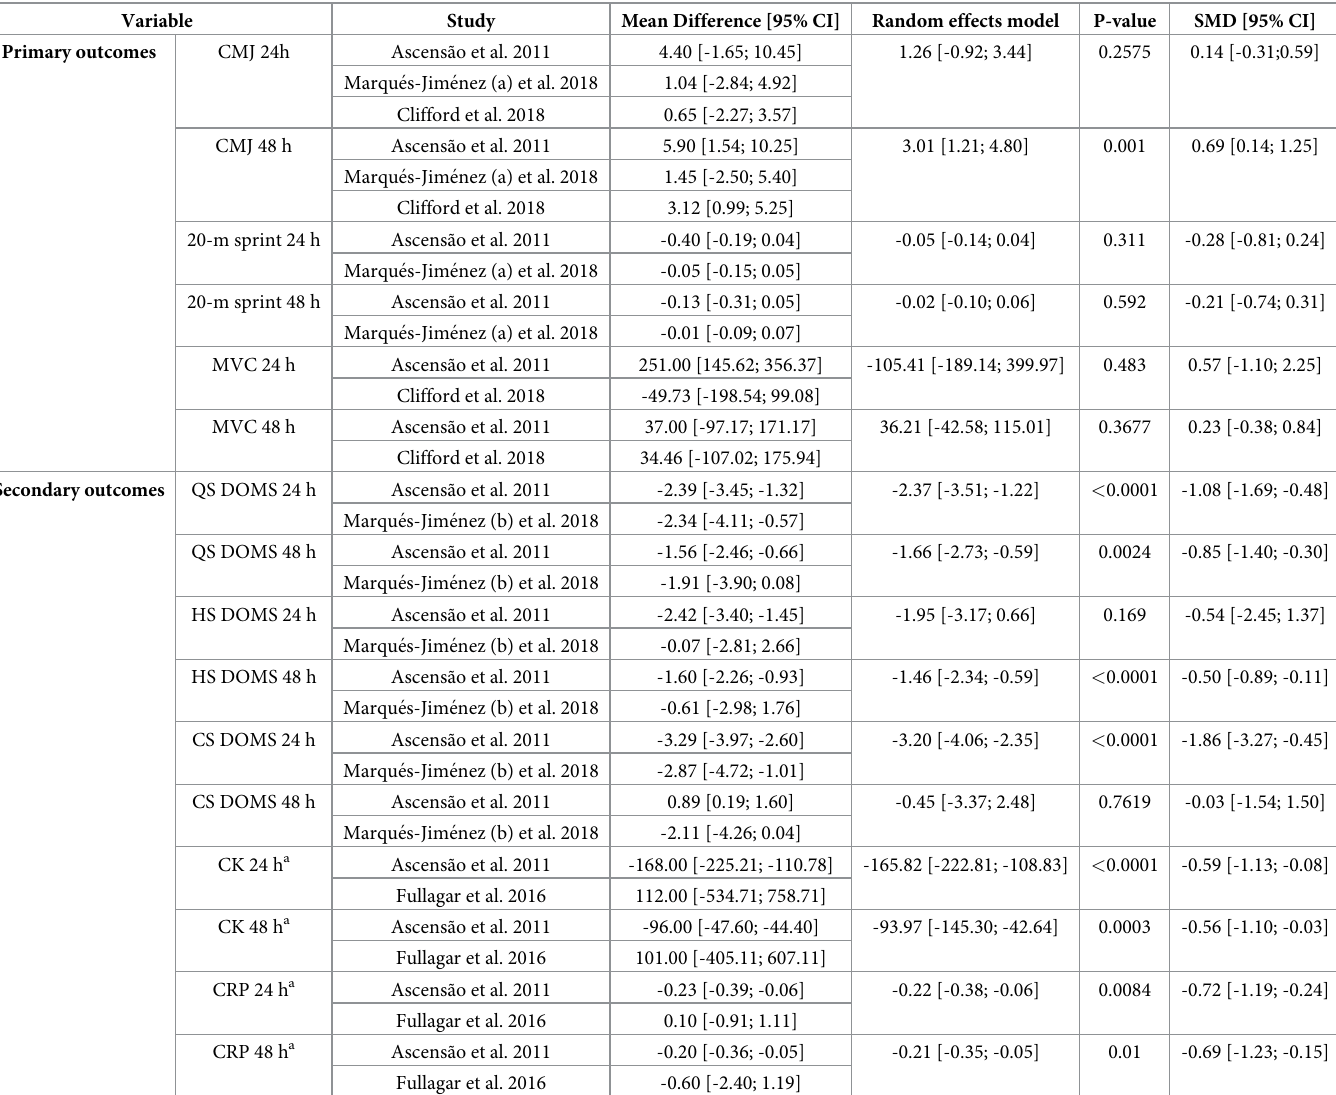
Table 3. Results from primary and secondary